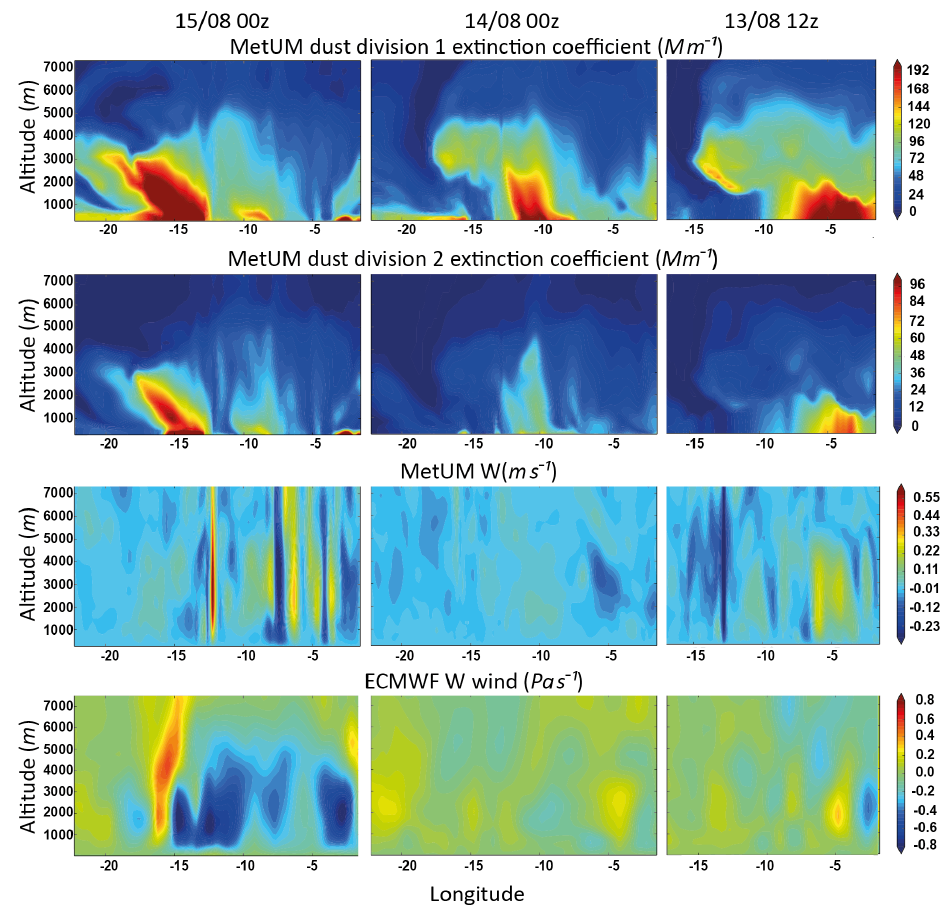
Figure 21. Contribution to the extinction coefficient by MetUM dust divisions d1 and d2 (top two rows), MetUM westerly wind component, and ECMWF–CAMS large-scale wind. These cross sections are extracted along the dust trajectory shown in Fig. 1 for case study 3 (flight B927, 15